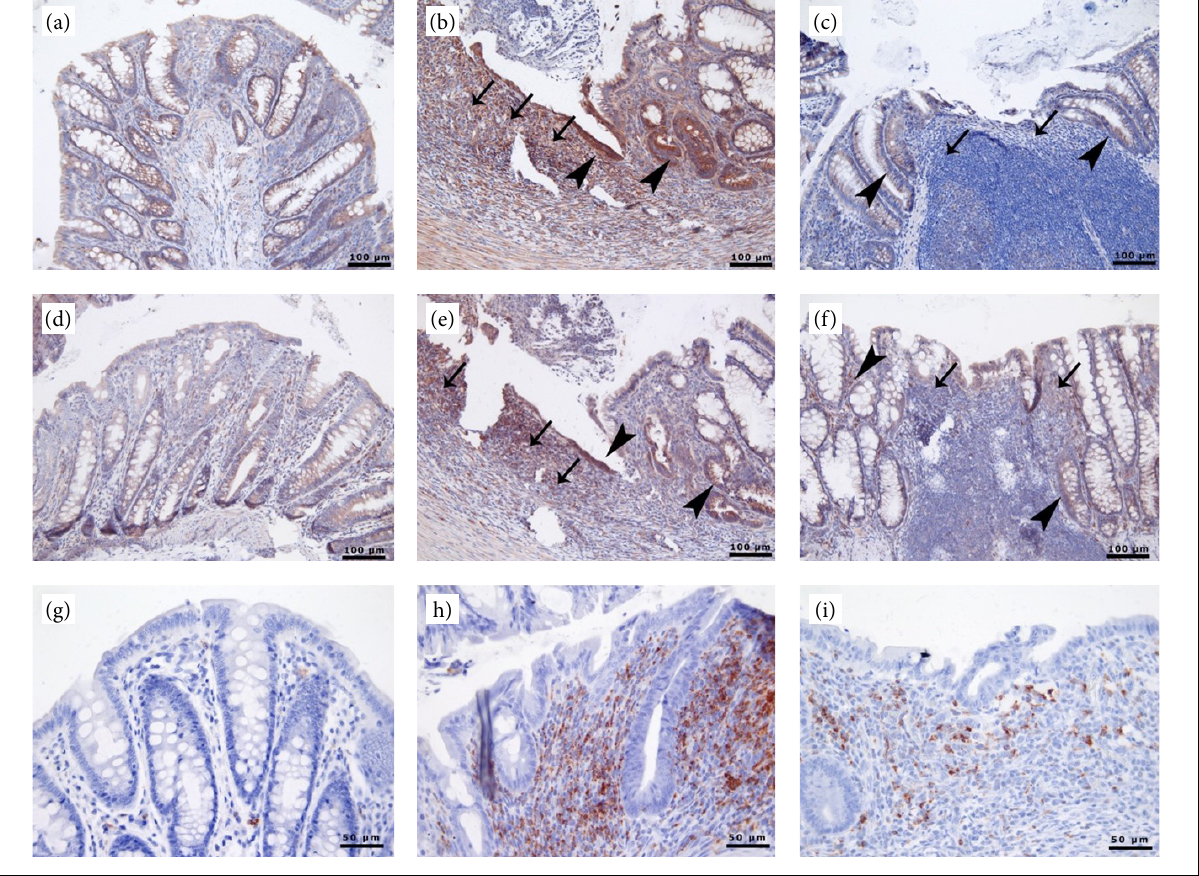
VEGF: vascular endothelial growth factor; TNF: tumor necrosis factor. Figure 2 - Immunohistochemical examination of the groups for VEGF, TNF and CD68. (a-c) VEGF: (a) Mild VEGF positivity in epithelia in the control group, (b) severe VEGF positivity in inflammatory cells ( arrows ) and epithelial cells ( arrowheads ) in group 1. (c) Decreased VEGF positivity in inflammatory cells ( arrows ) and epithelial cells ( arrowheads ) in group 2. (d) D-F: TNF- α : Mild TNF- α positivity in epithelia in the control group, (e) severe TNF- α positivity in inflammatory cells ( arrows ) and epithelial cells ( arrowheads ) in group 1. (f) Decreased TNF- α positivity in inflammatory cells ( arrows ) and epithelial cells ( arrowheads ) in group 2. (g-i) (g) CD68: few positive macrophages ( red cells ) in the control group, (h) many positive cells among inflammatory cells in group 1, (i) decreased CD68 positivity among inflammatory cells in group 2. ABC-peroxidase method, AEC chromogen, Gill’s hemalum. Bar = actual